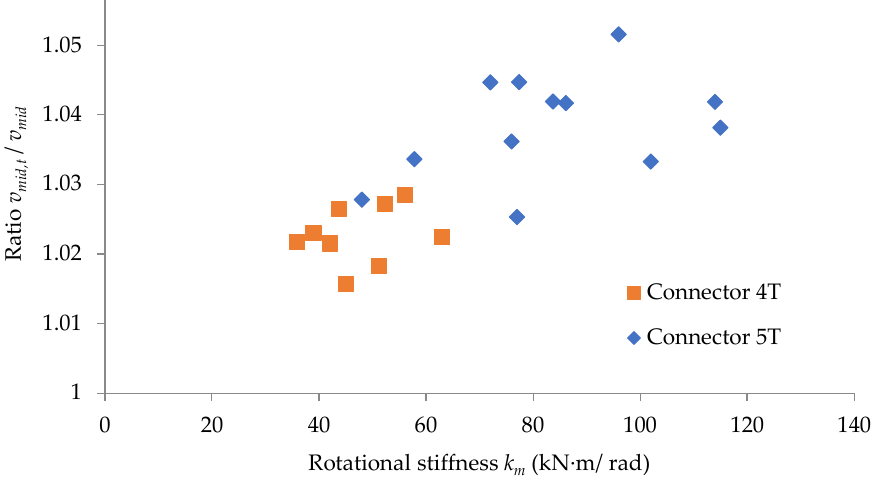
Figure 15. Variation of the ratio 𝑀 (cid:3040)(cid:3036)(cid:3031),(cid:3047) 𝑀 (cid:3040)(cid:3036)(cid:3031) ⁄ related to the rotational stiffness k m of the connection for each type of tabs connector involved.